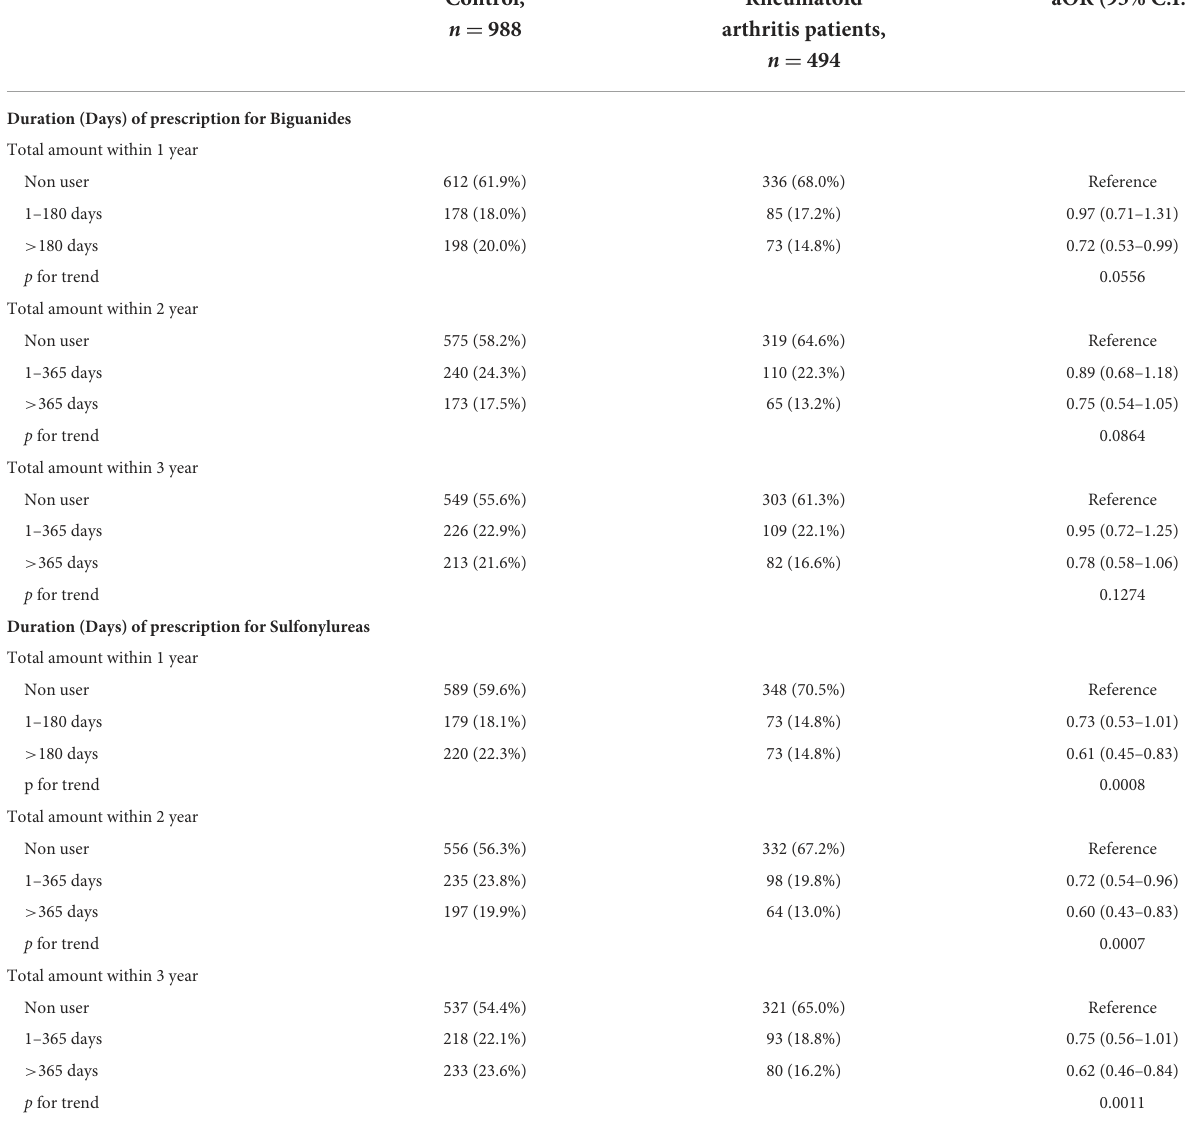
TABLE 5 Nested case-control study design to evaluate the days of prescription for biguanides and